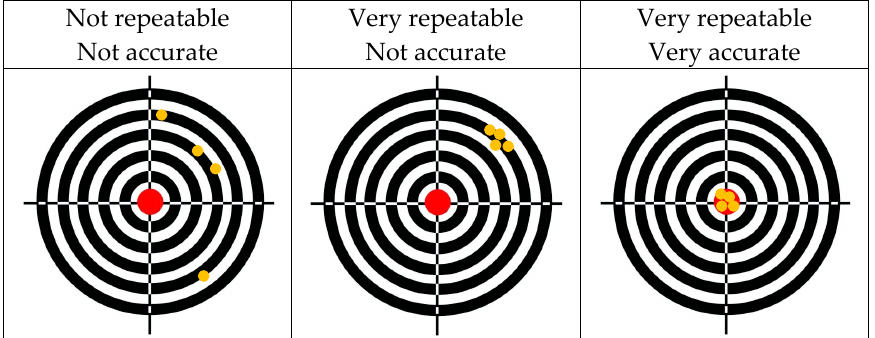
Figure 17. Illustration of the concepts of accuracy and repeatability of measurements repeated within